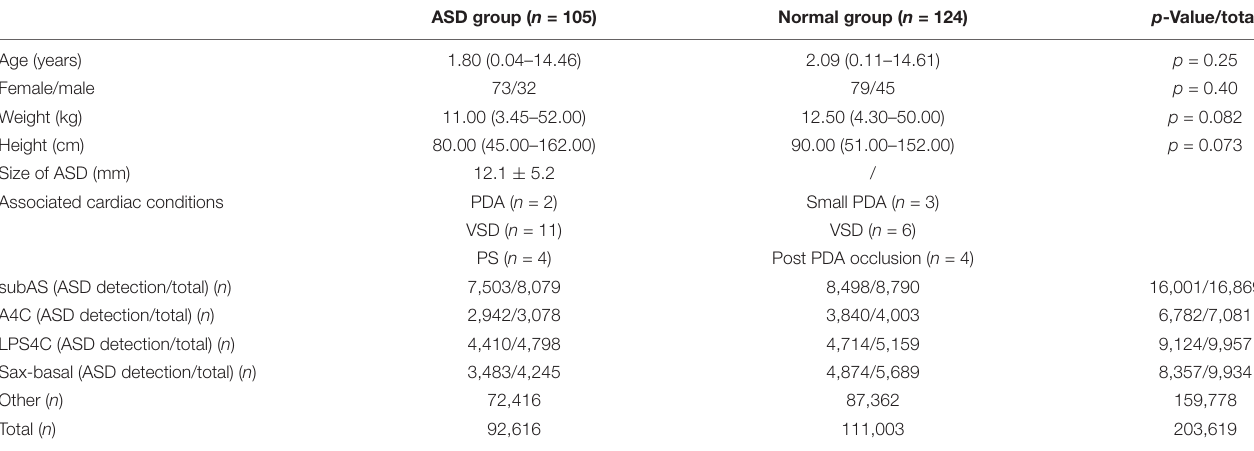
TABLE 2 | Clinical characteristic and view distribution comparisons between the ASD group and the normal group of the test data set. ASD group ( n = 105)